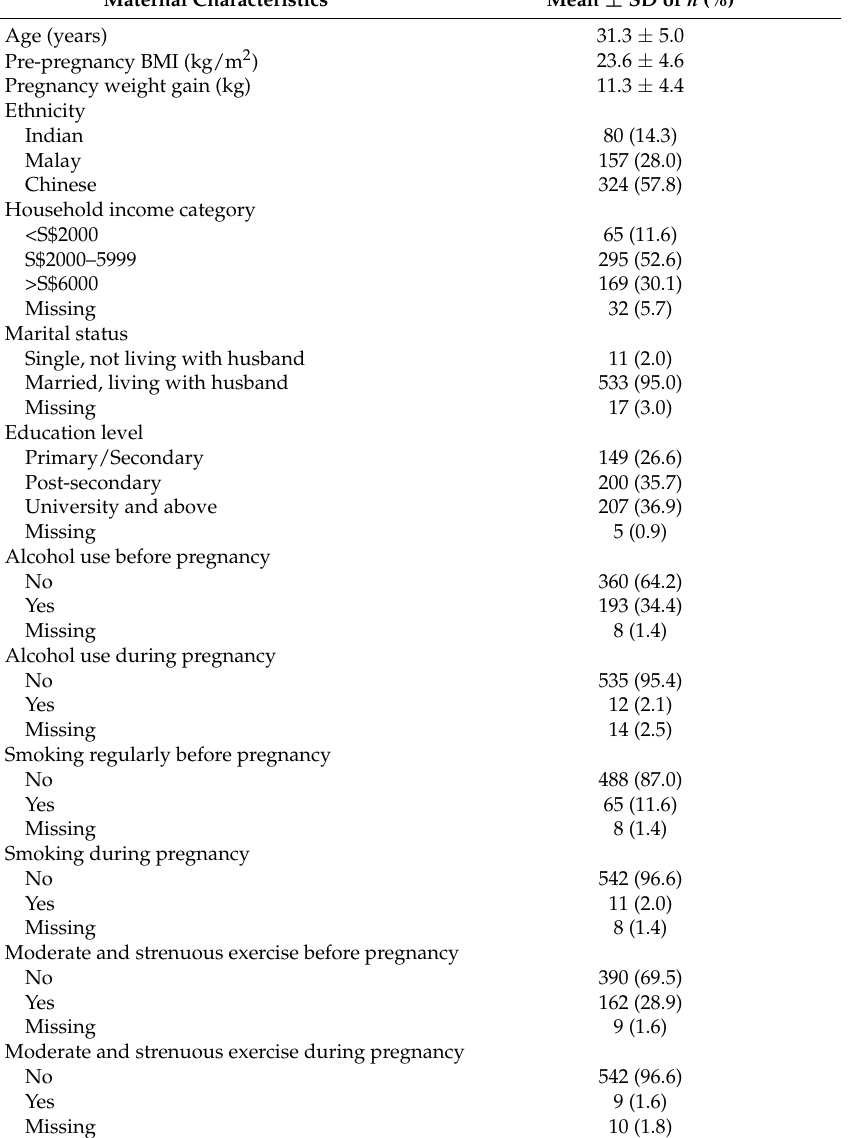
Table 2. Sociodemographic and lifestyle characteristics of GUSTO participants with toddler dietary information at 18 months ( n =